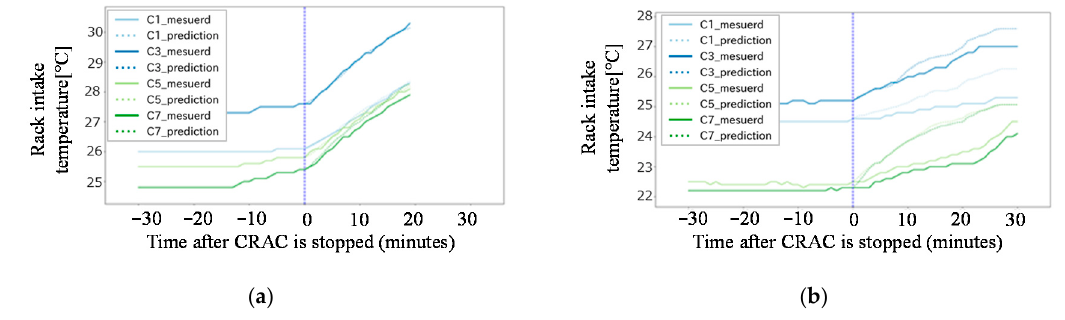
Figure 15. Time-series changes of rack intake temperature in C rack row. ( a ) Rack intake temperature in C rack row (in the case of one CRAC suddenly stopping while only one CRAC is operating). ( b ) Rack intake temperature in C rack row (in the case of one CRAC suddenly stopping while two CRACs are operating).